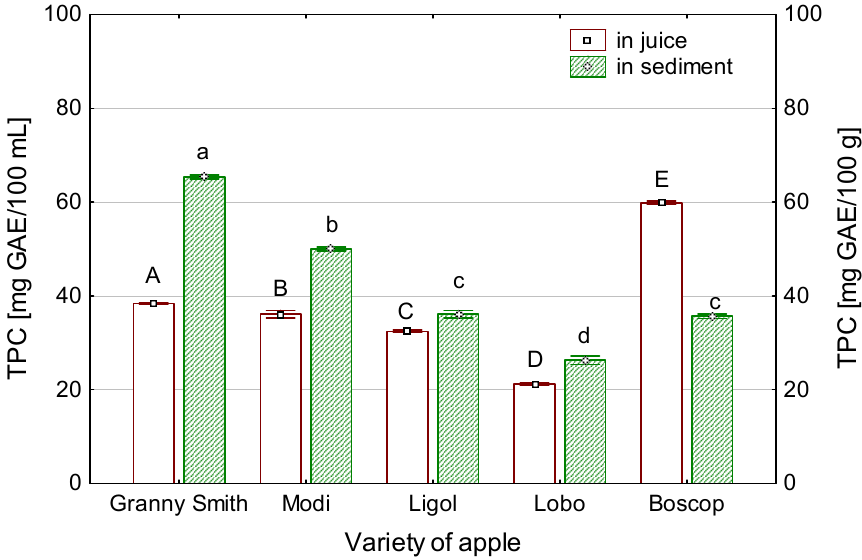
Figure 6. Influence of variety properties on total polyphenol content (TPC) in juice and in the sediment in juice. Different capital letters indicate values significantly different at p < 0.05 in juices. Different lowercase letters indicate values significantly different at p < 0.05 in sediment.